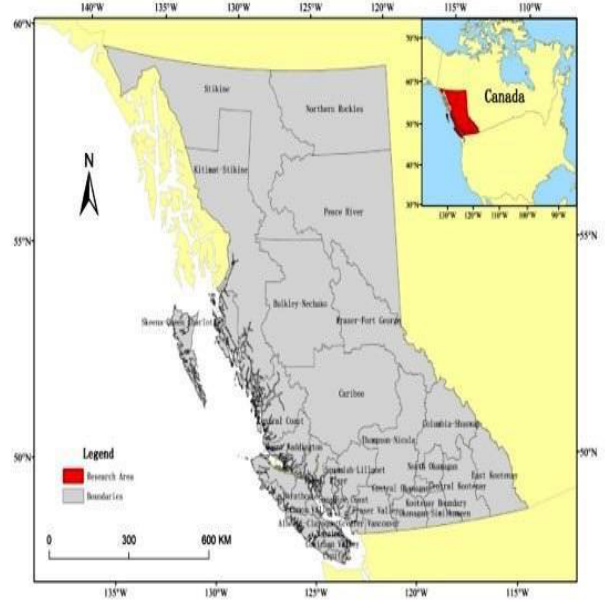
Fig. 1. Study area: British Columbia,